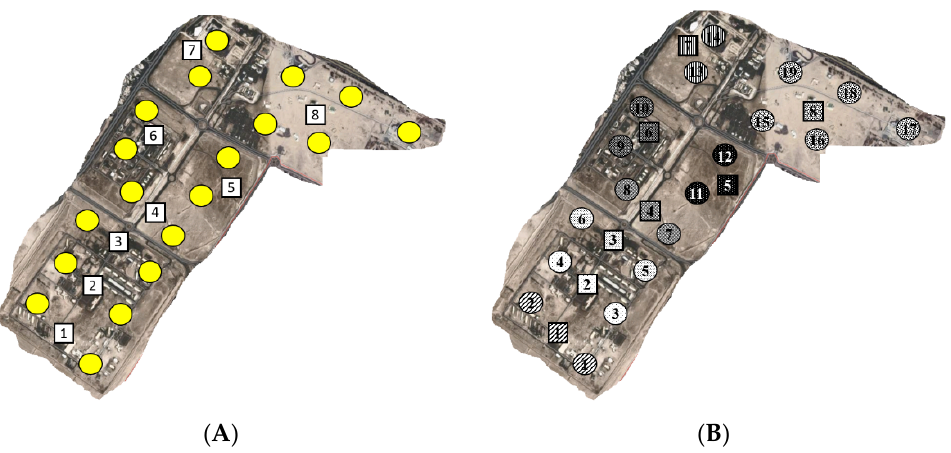
Figure 7. ( A ) Resulting zonal cluster where location nodes (in yellow) are grouped to the zone clusters (square); ( B ) Pattern matching between zones and allocated locations. Table 1. Land-use